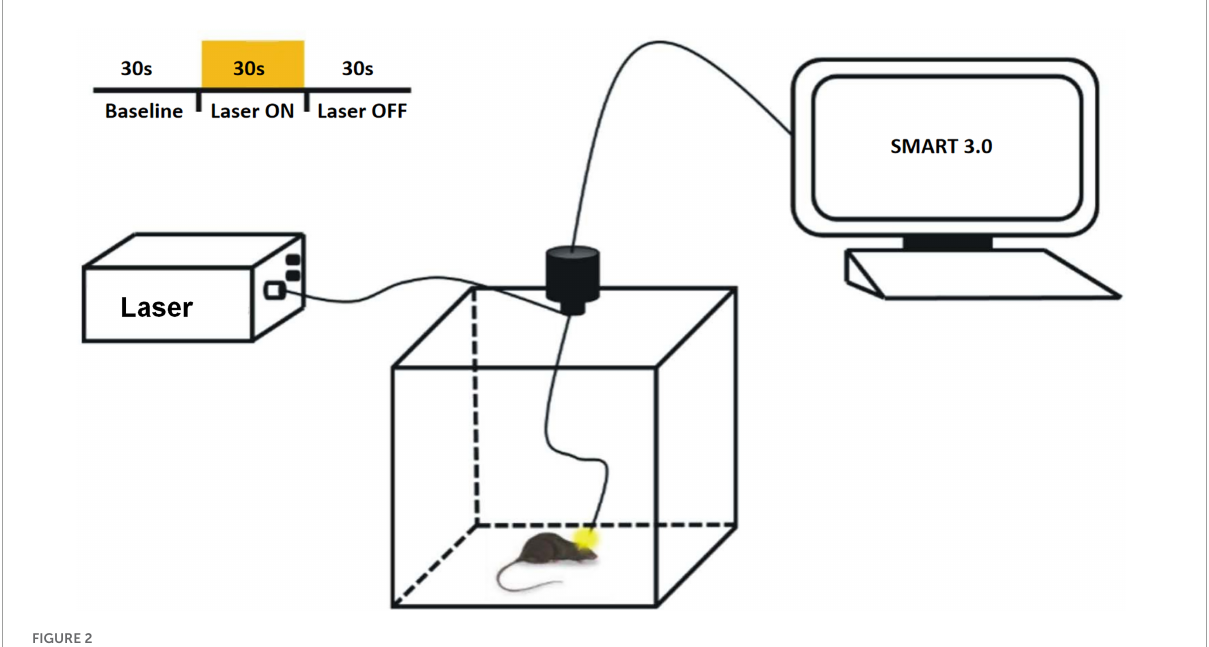
FIGURE2 Optogenetic experiments